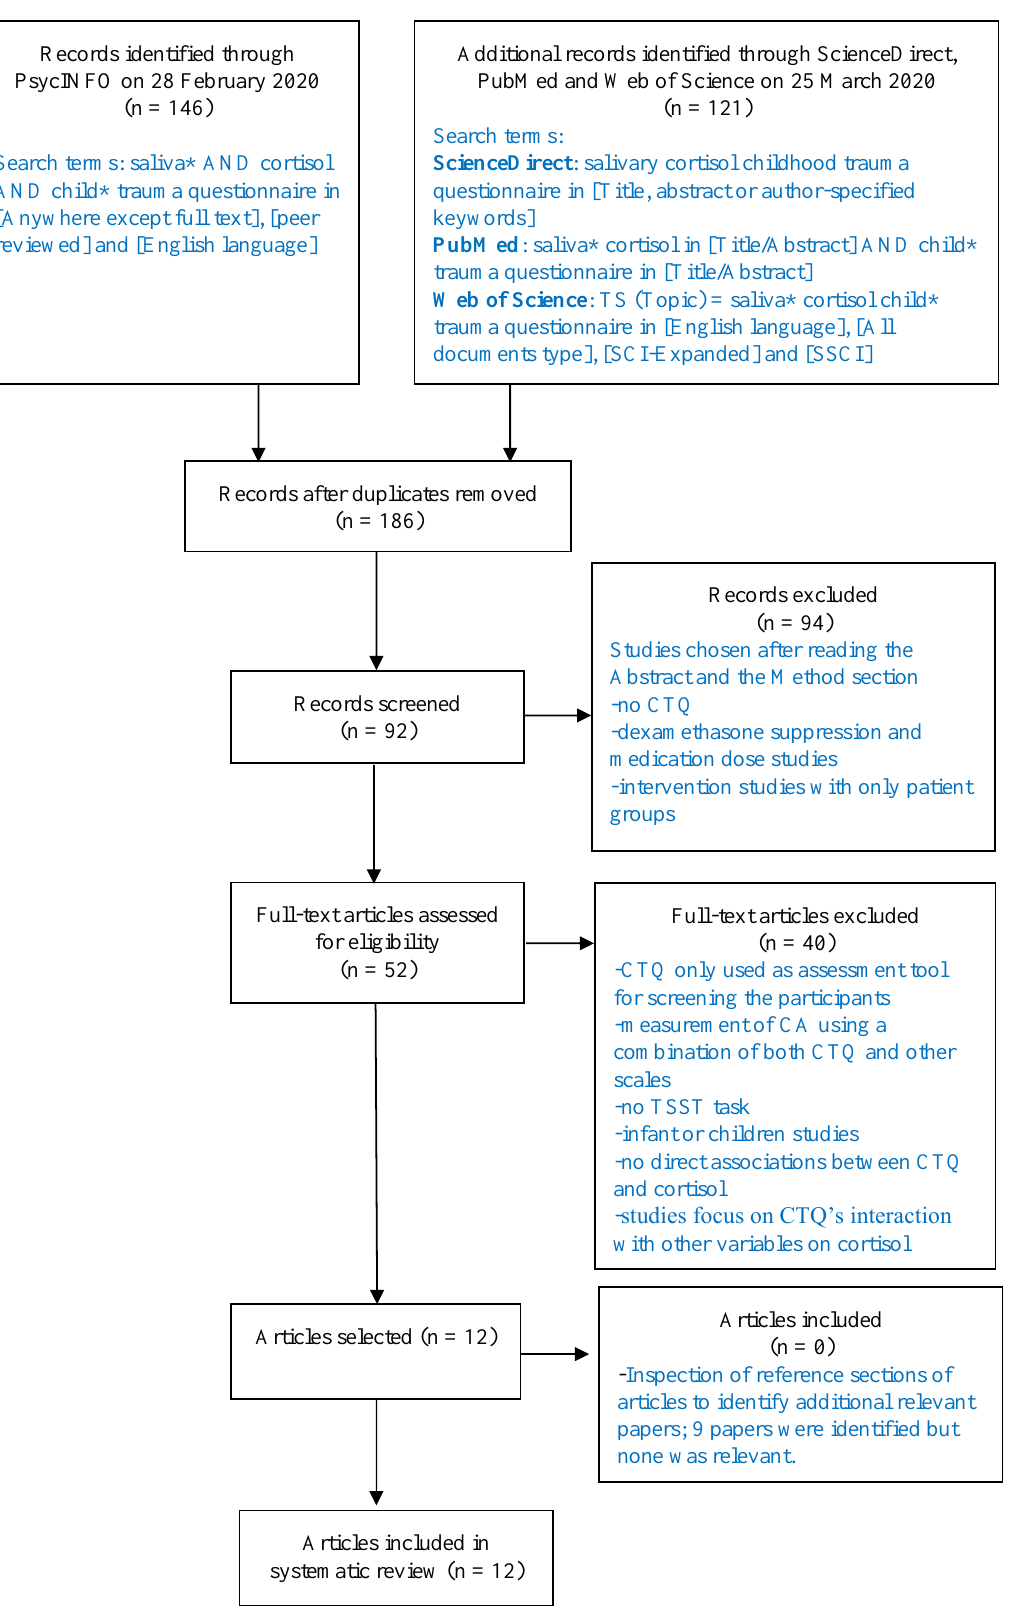
Figure 1. Study selection flow